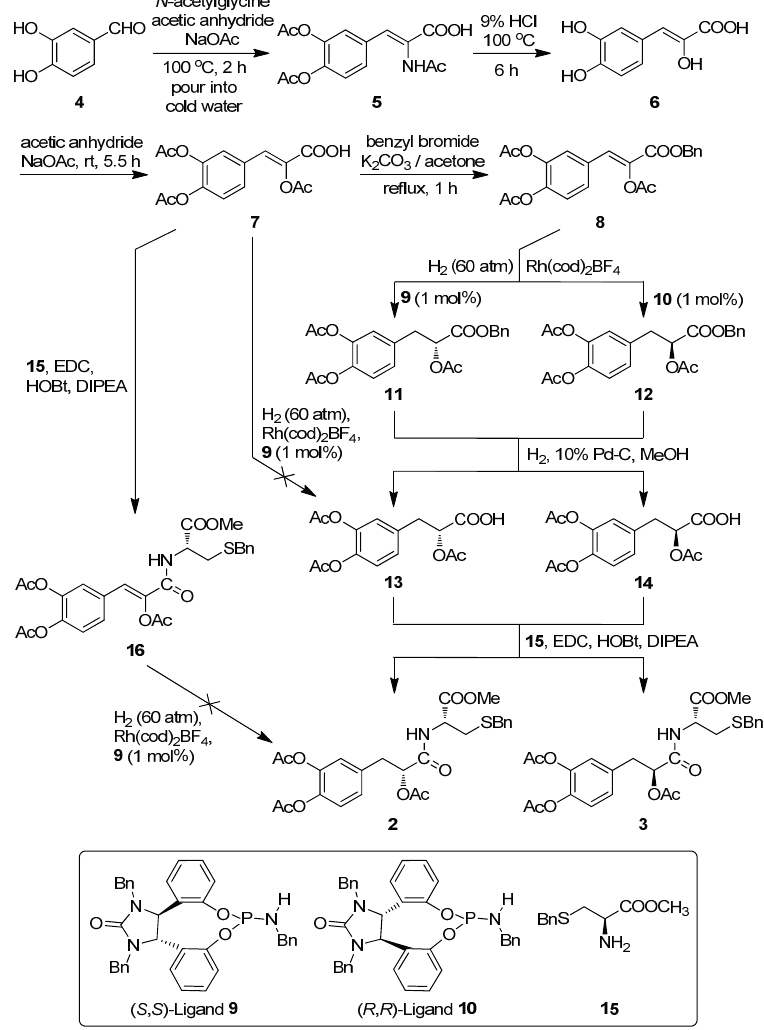
Figure 2. The synthesis of target diastereoisomers 2 and 3